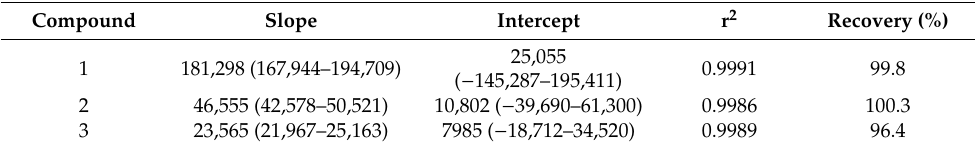
Table 2. Slope, intercept, r 2 , and recovery of the two UHPLC